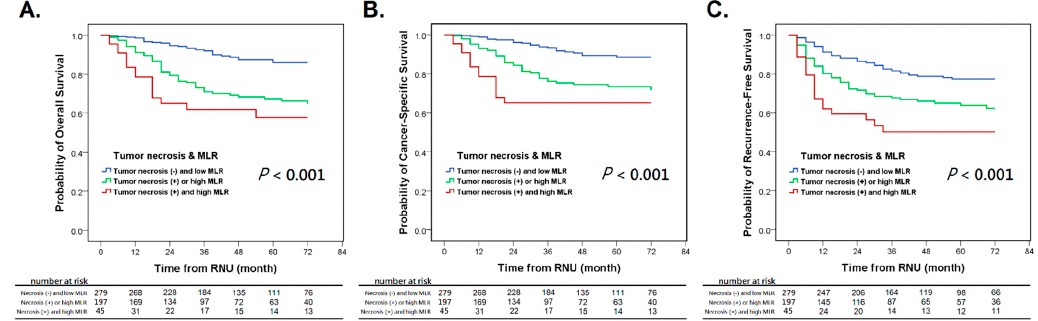
Figure 2. Kaplan–Meier survival curves for overall survival ( A ), cancer-specific survival ( B ), and recurrence-free survival ( C ) in UTUC patients who were divided into three groups based on tumor necrosis and preoperative MLR. UTUC: upper tract urothelial carcinoma, MLR: monocyte-to-lymphocyte ratio.